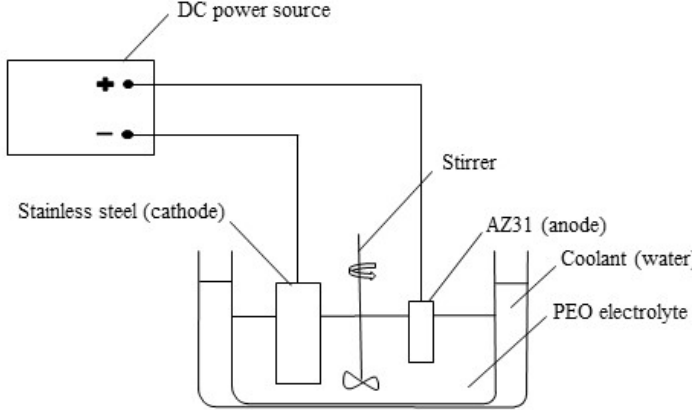
Figure 1. Scheme of plasma electrolytic oxidation (PEO)